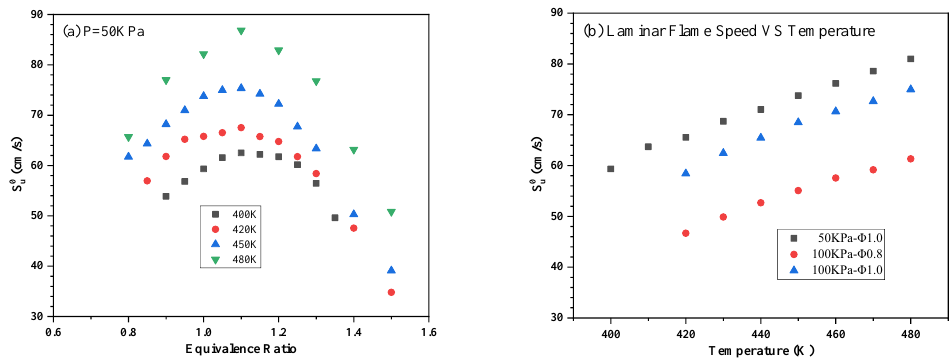
Figure 6. 𝑆 𝑢0 of aviation kerosene ( a ) at 50 kPa and different initial temperatures as functions of the equivalence ratio and ( b ) at various initial pressures and Φ as functions of temperature.